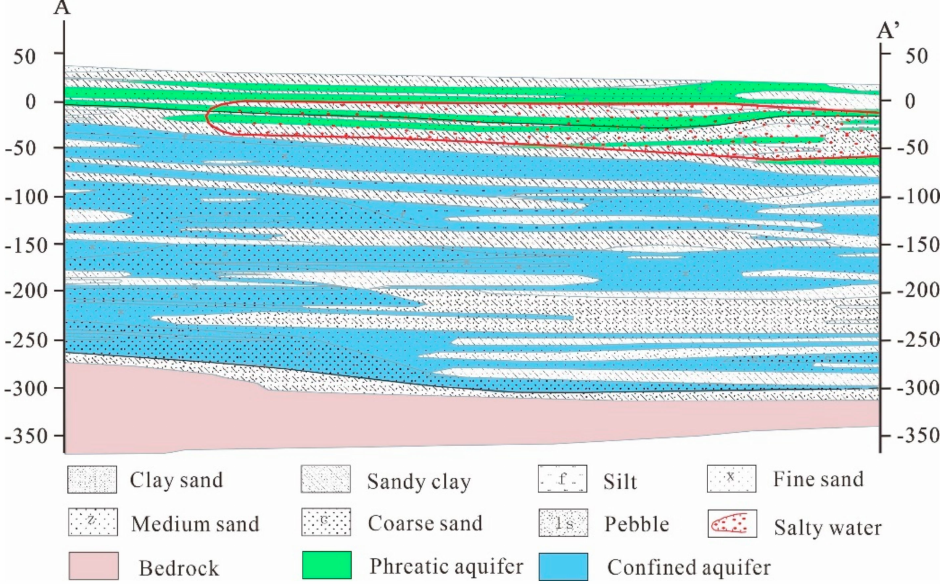
Figure 2. Hydrogeological section along the A-A’ in the study